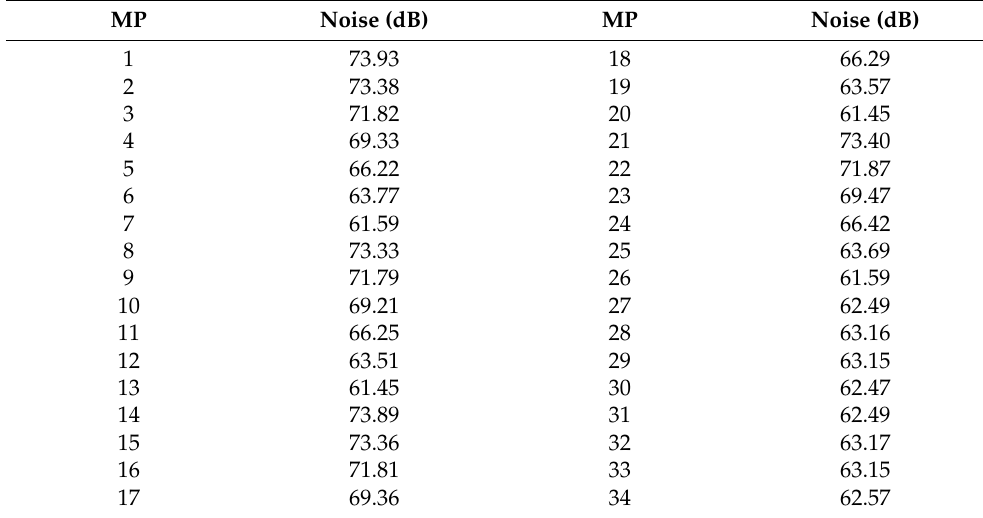
Figure 10. The 3D model of power transformer. Table 7. Noise data from measurement